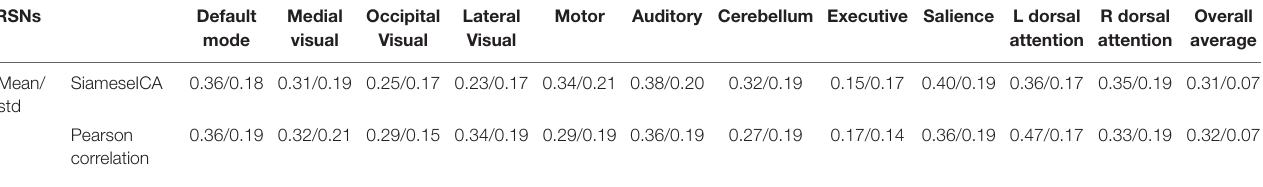
FIGURE 11 | Voxel-wise intraclass correlation (ICC) values ( ≥ 0.4) showing the scan-rescan reproducibility on classifying 11 RSNs using the proposed SiameseICA model and template matching method. TABLE 1 | Mean and standard deviation of the ICC values for 11 RSNs using the proposed SiameseICA model and Pearson Correlation (with five samples per class).